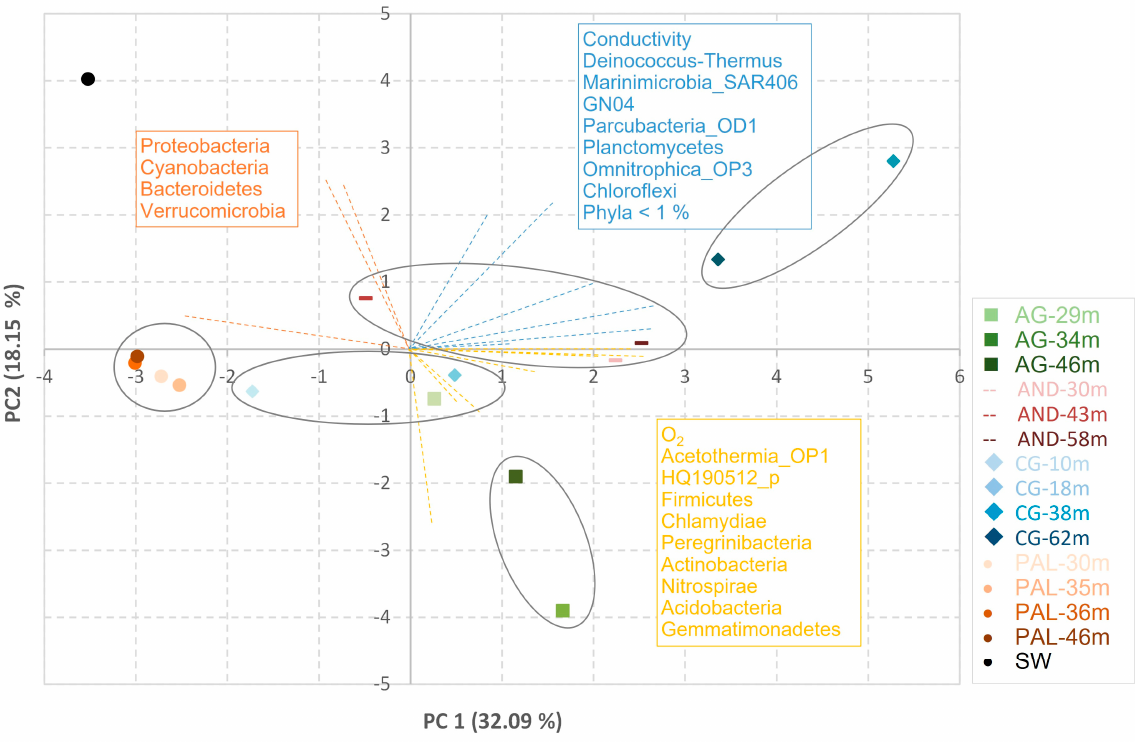
Figure 6. PCA-biplot analysis of microbial data at phylum taxonomic level. The nearest neighbor algorithm and square Euclidean distance were applied for hierarchical clustering of samples.